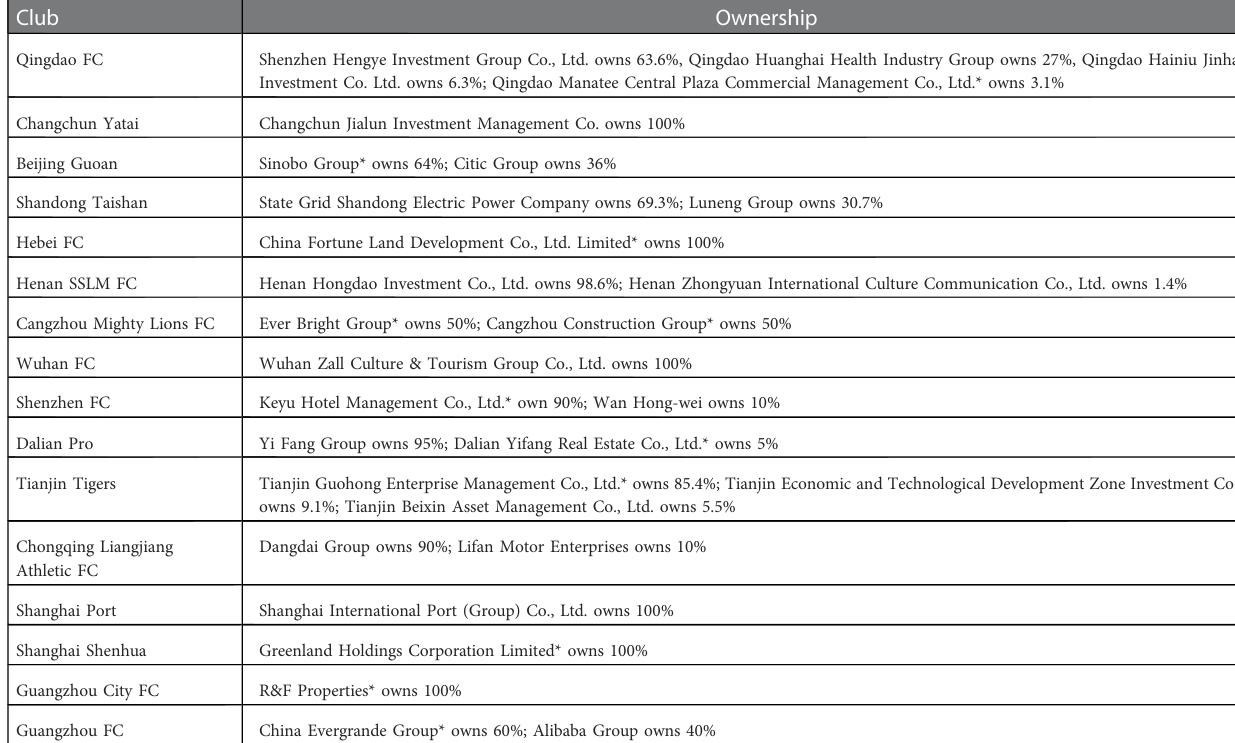
TABLE 1 Shareholder structure of the Chinese super league clubs in 2021.